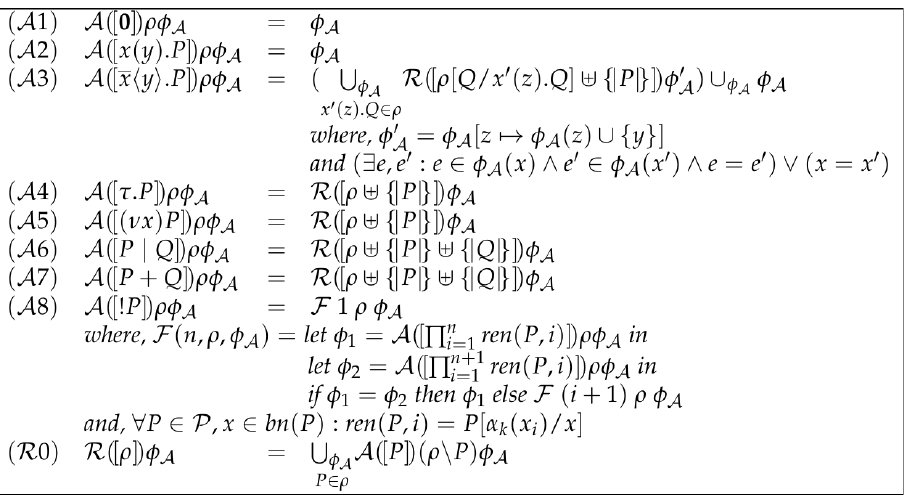
Figure 2. A name-substitution abstract semantics for the π